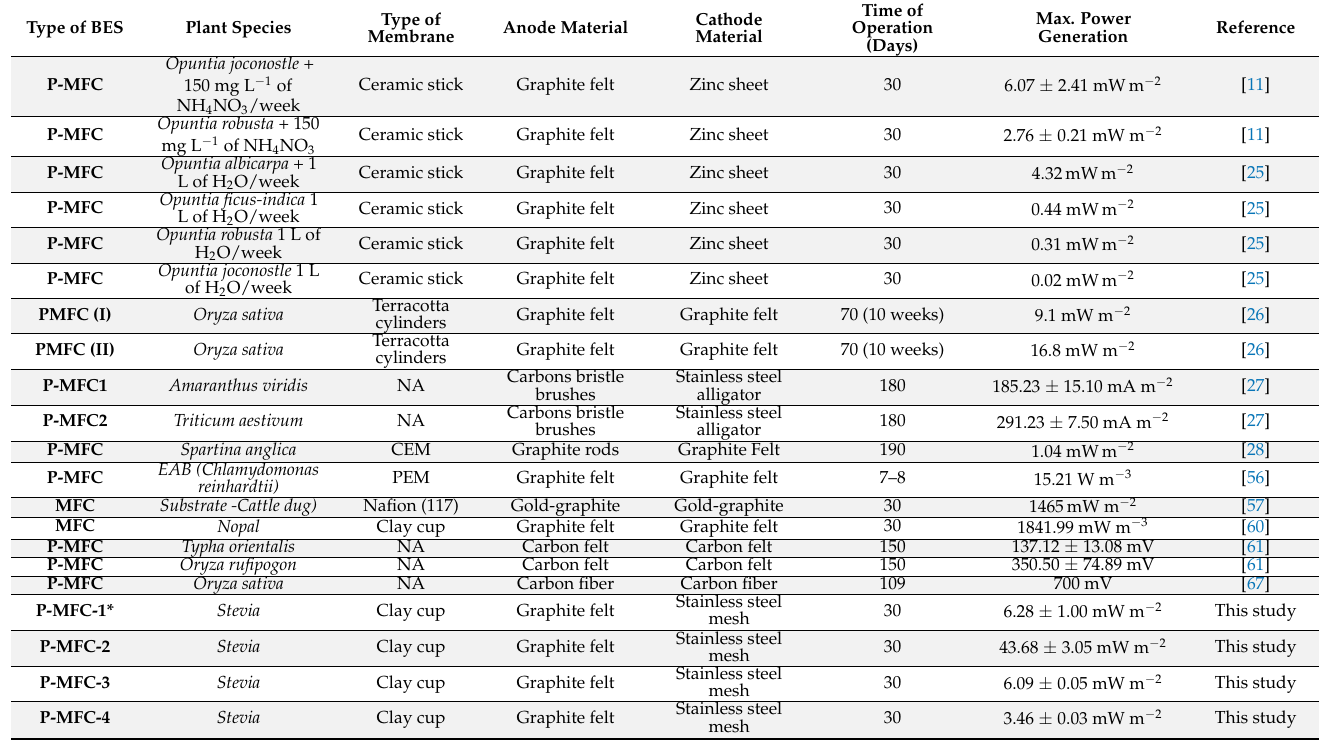
Table 1. Performance of P-MFCs reported in the previous